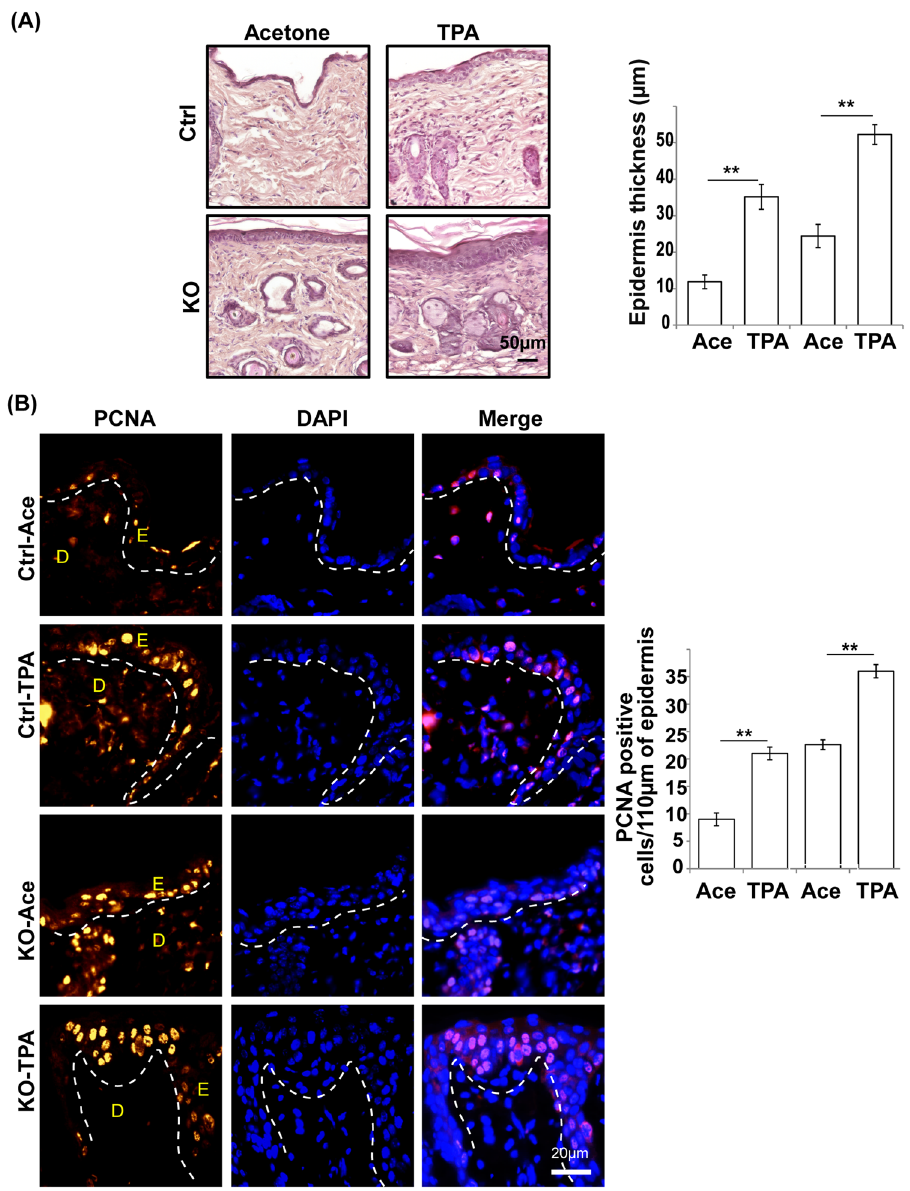
Figure 3. TPA-induced hyperproliferation in N-WASP K14KO mice. (A) H & E staining of dorsal skin of control and N-WASP K14KO mice 24 hours following application of solvent (acetone) or TPA. (B) Immunostaining and quantification of PCNA-positive cells in TPA treated skin from control and N-WASP K14KO mice. (Ace: Acetone) Results are mean ± SEM *** p < 0.001, ** p < 0.01, (n =